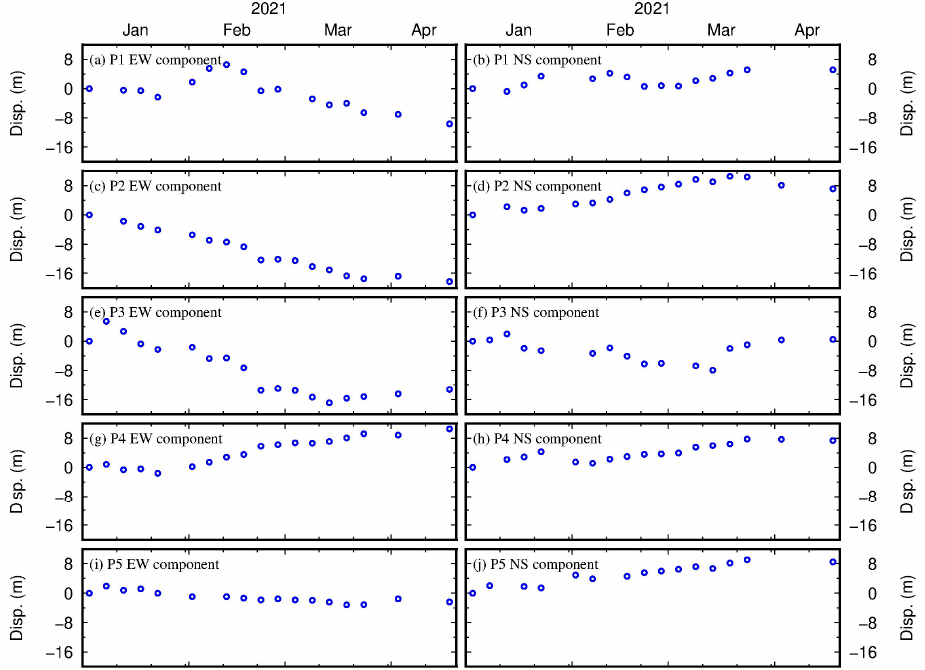
Figure 8. ( a – j ) represent the time series of accumulated displacement monitoring results from P1–P5. The locations of the points are illustrated in Figure 6(A1). The displacement values in the east and north directions are positive.